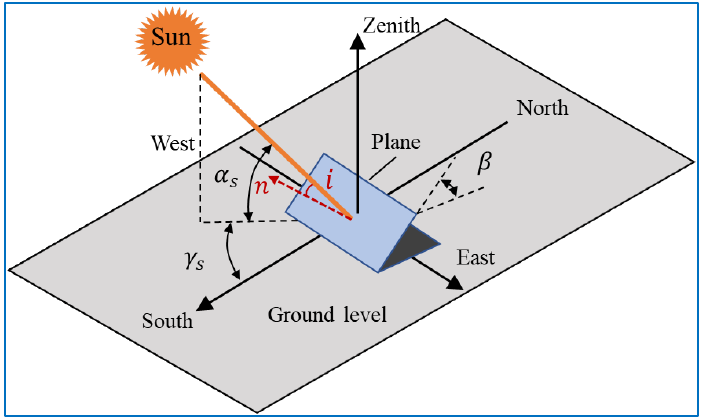
Figure 2. The relative position relationship between the sun and the inclined plane.